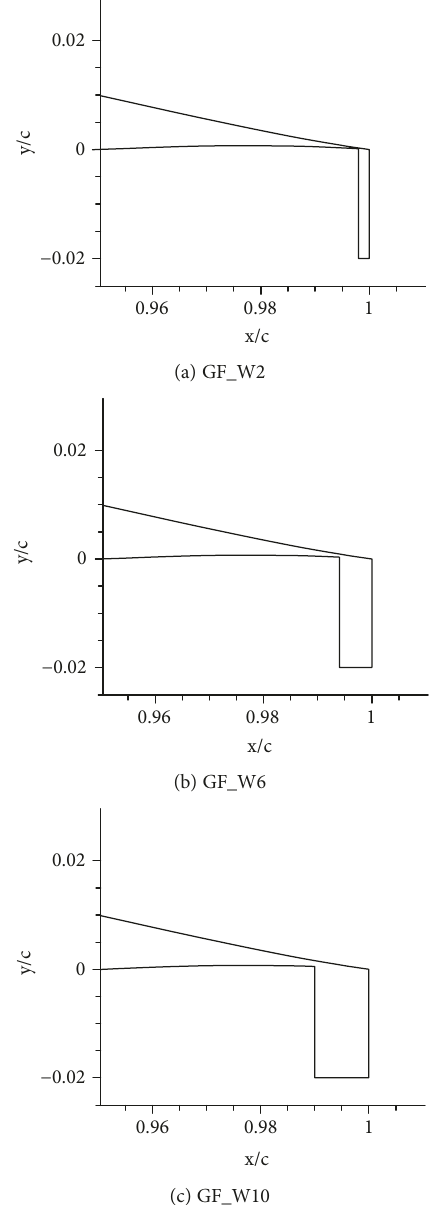
Figure 4: Schematic diagram of the three Gurney fl ap